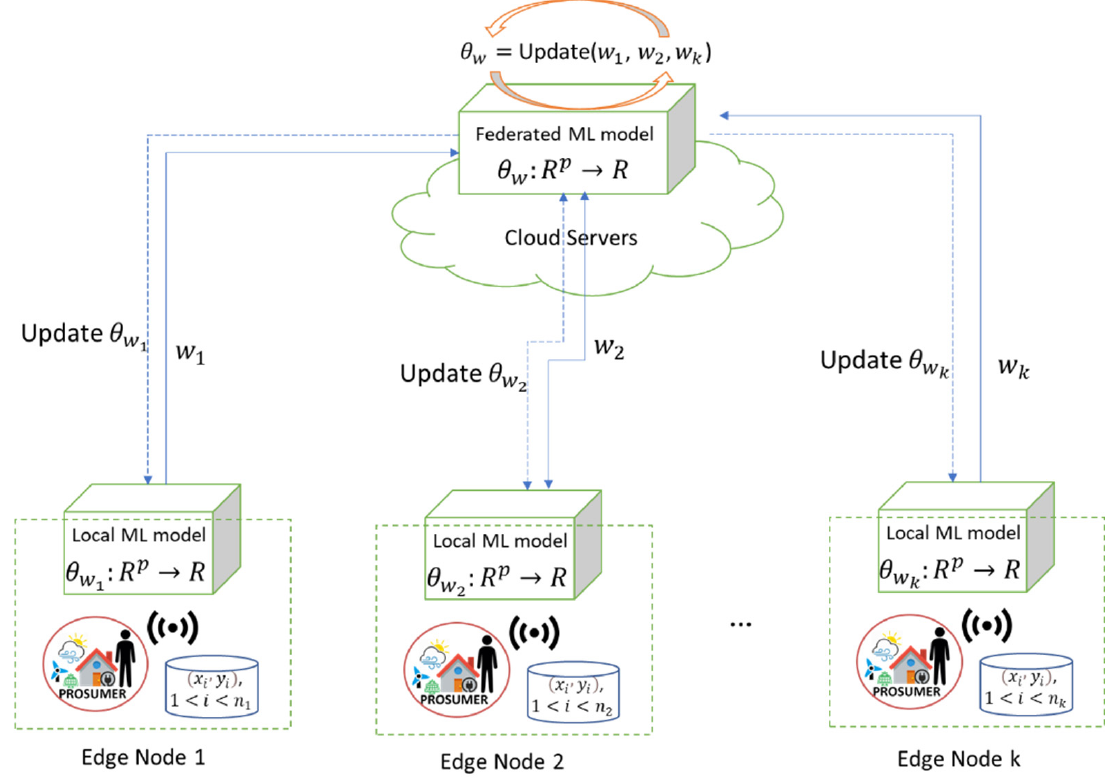
Figure 2. FL for prosumers’ energy-demand prediction. The models are trained locally by each of the k edge nodes associated with the energy prosumers, obtaining a set of parameter vectors w i for each learned function θ w minimizes a prediction error